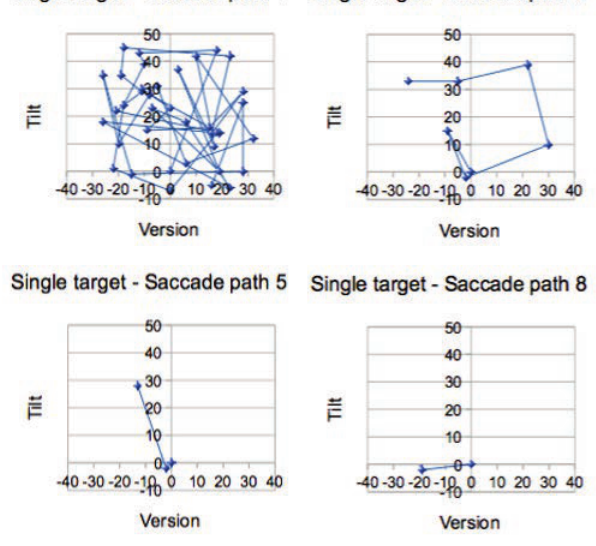
Figure 5. Motor movements for fixating on a single target. Movement tracks are taken from saccades 1, 3, 5 and 8 showing the rapid early devel- opment. Movements are relative to the target